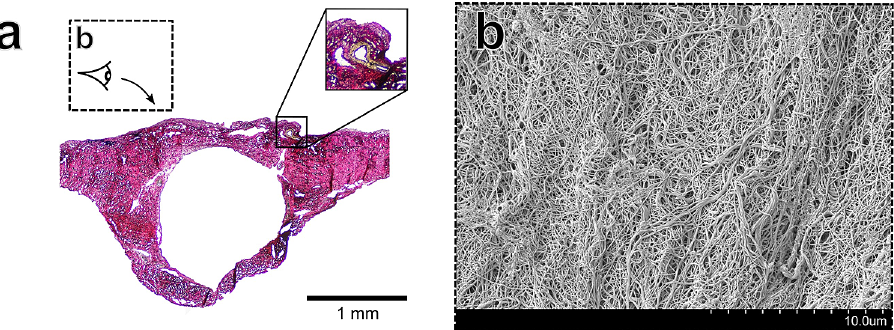
Figure 3. Structural images of the frontal region of the SSS ( a ) Verhoeff–Van Gieson stained sample of the frontal region. The solid-line inset image shows what appears to be a meningeal artery ( b ) SEM imaging of the bone surface layer (as illustrated in dashed-line inset of ( a )) showing disorganised focal aggregations of collagen fibres.